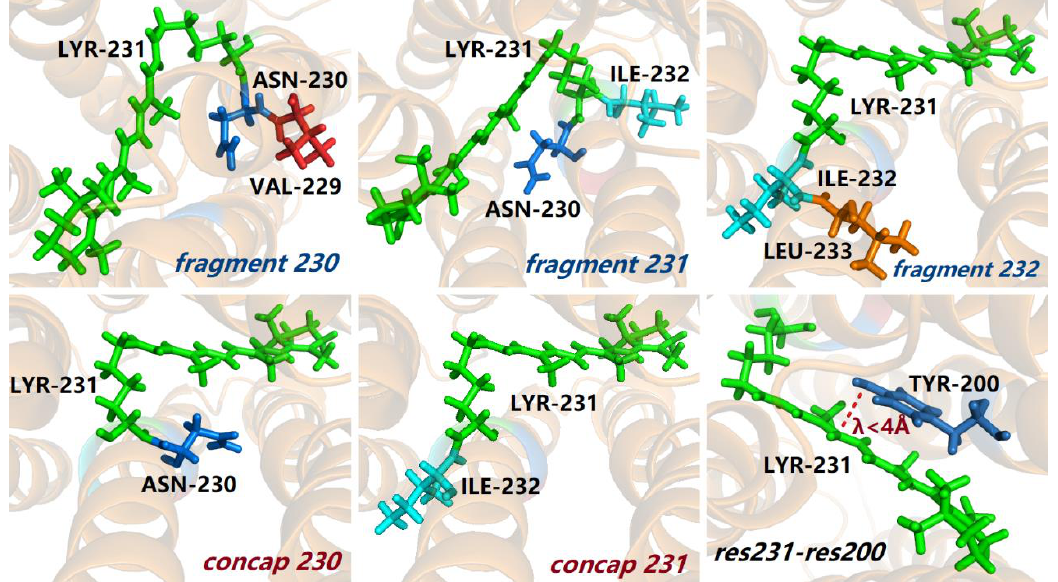
Figure 1. Graphical representation of fragments, concaps, and 2B QM interaction. The background α-helix cartoon of the PR protein with 80% transparency is described by background charges, whereas the sticks of the corresponding residues represent the QM region in the EE-GMFCC calculation. The green sticks denote the chromophore LYR231. The structures all come from the same configuration of the PR protein.